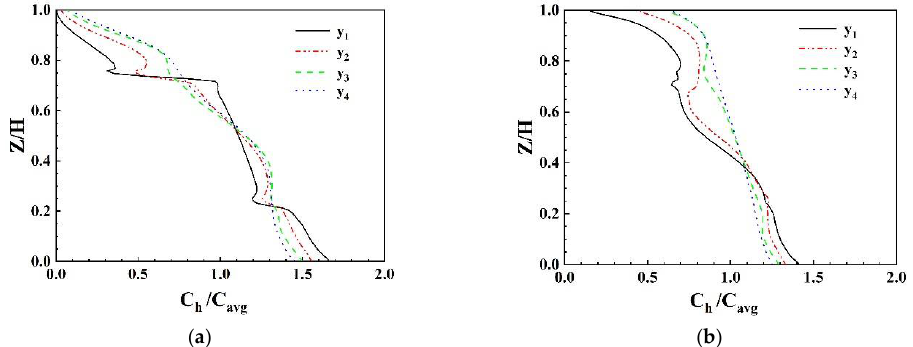
Figure 8. Axial solid concentration profile at different axial locations. ( a ) DTBI; ( b ) DRFTBI. (Rota- tional speed: 120 rpm; solid loading: 30%; connection strap length: 1.2 H S .)